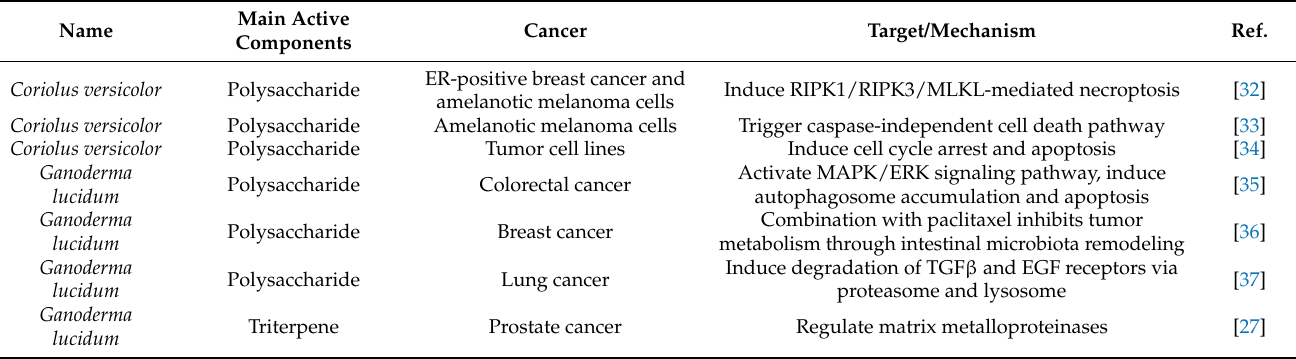
Table 1. Summary of the anticancer activities of edible and medicinal